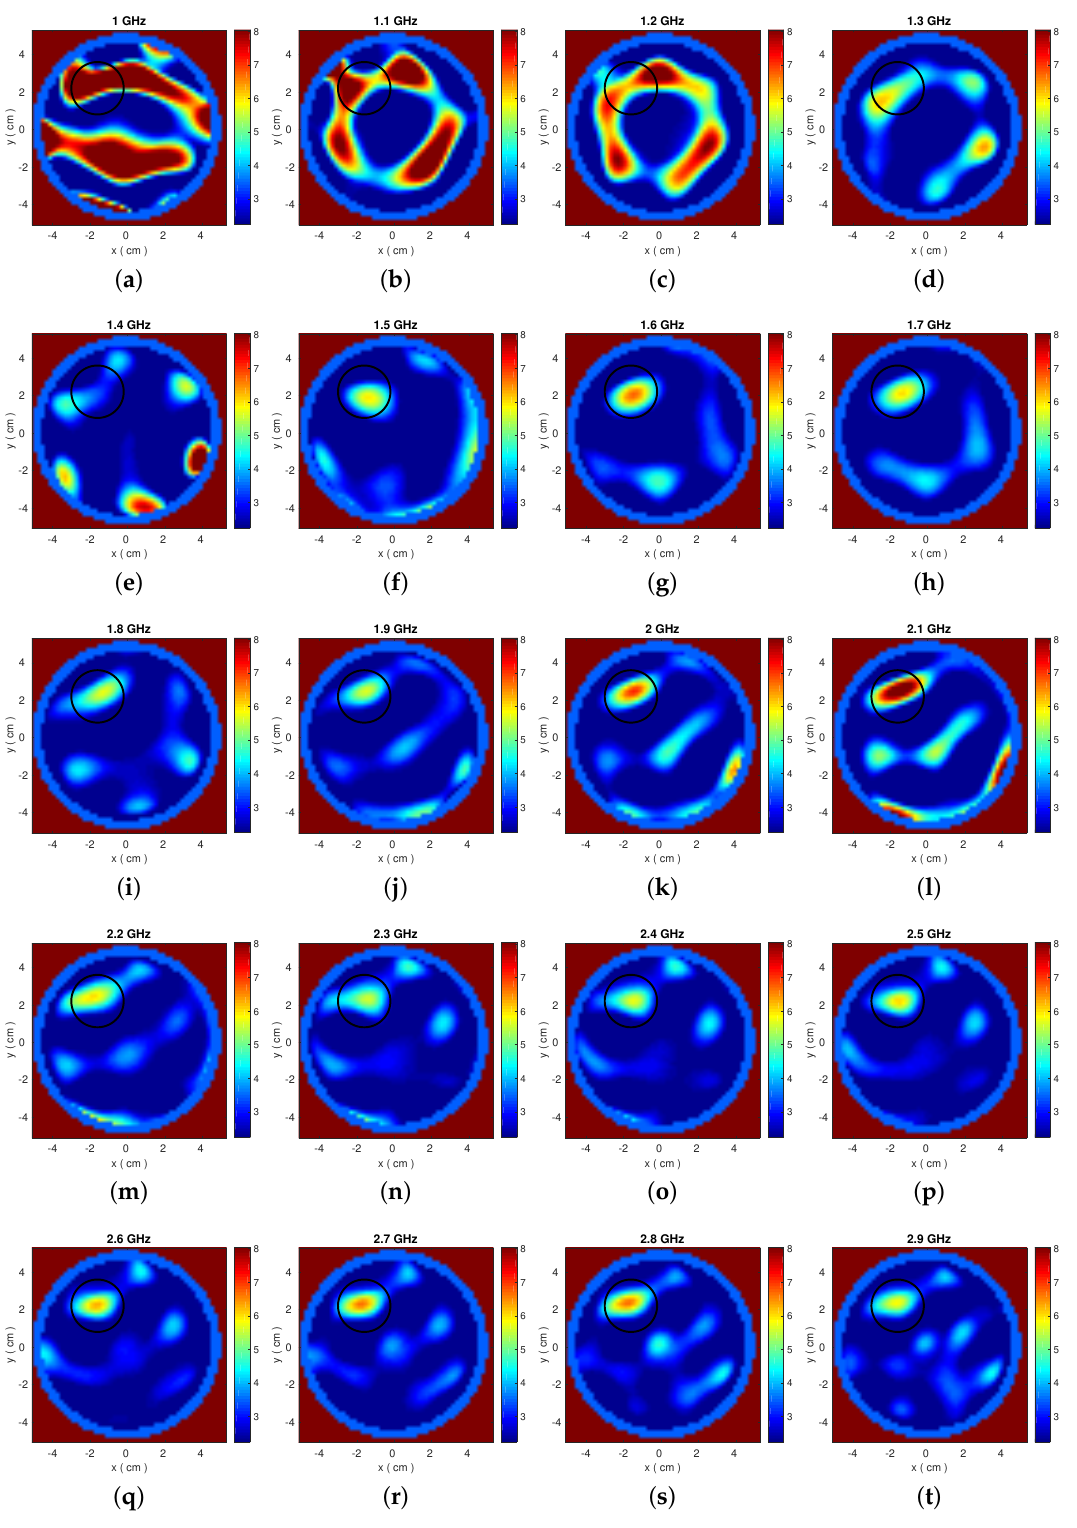
Figure 9. ( a – t ): Single-frequency reconstructions of the Debye parameter (cid:101) ∞ from 1.0 to 2.9 GHz using the experimental dataset from our two-layer cylindrical